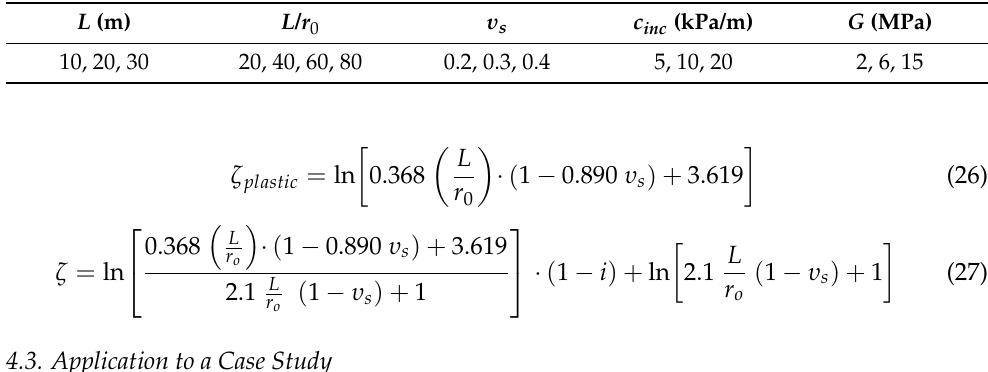
Table 4. Combination of pile geometries and